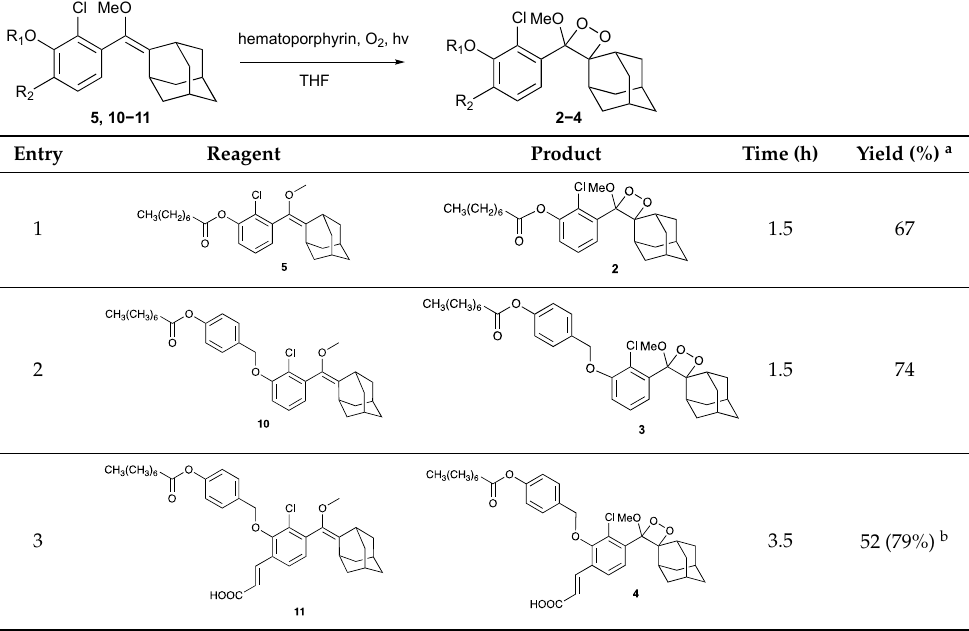
Table 1. Synthesis of final compounds 2 – 4 by radical oxidation of precursors 5 , 10, and 11 .